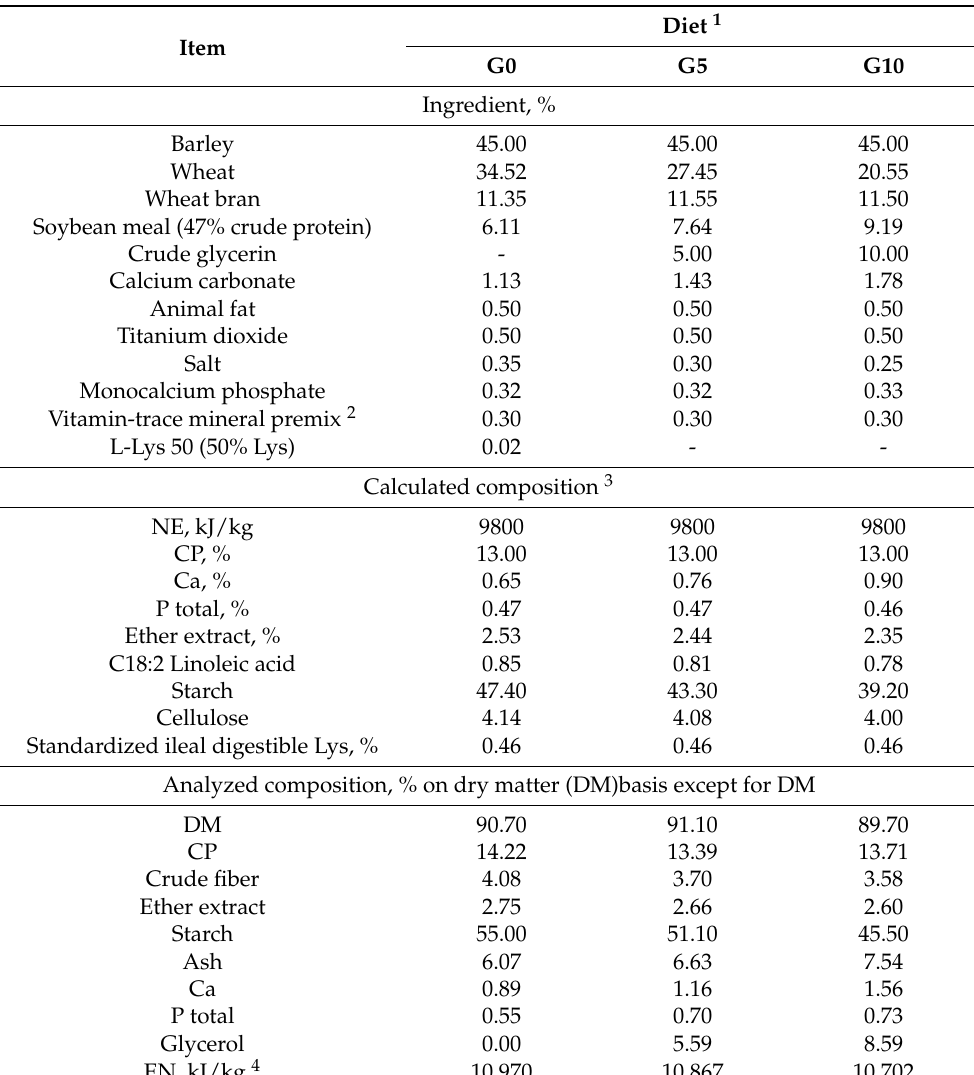
Table 1. Ingredients and composition of diets (as